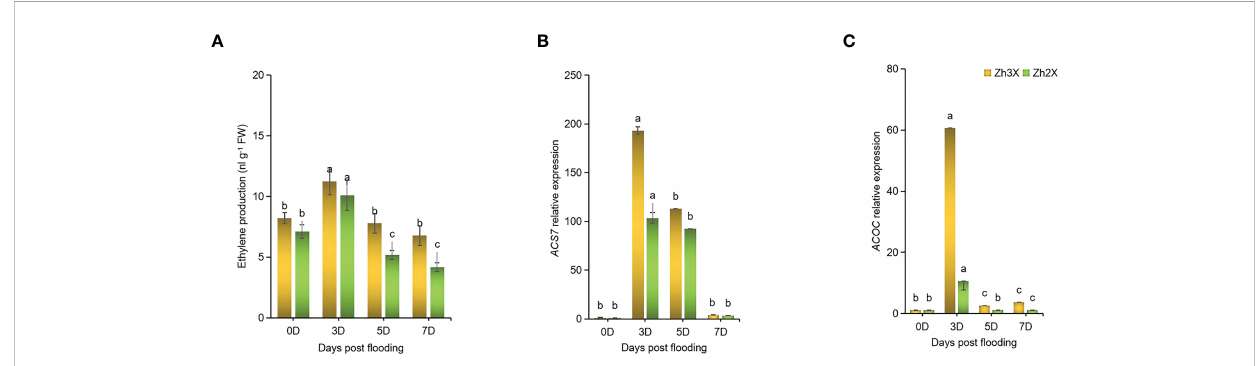
FIGURE 6 Fluctuations in Ethylene Biosynthesis in response to fl ooding. (A) Production of ethylene under fl ooding at different days post fl ooding. (B) Expression patterns of WmACS7 as well as (C) WmACOC in watermelon leaves under fl ooding. Perpendicular bars display averages ± SD (n = 6). Lower case letters above each bar present signi fi cant changes at p < 0.05 (Duncan ’ s multiple range